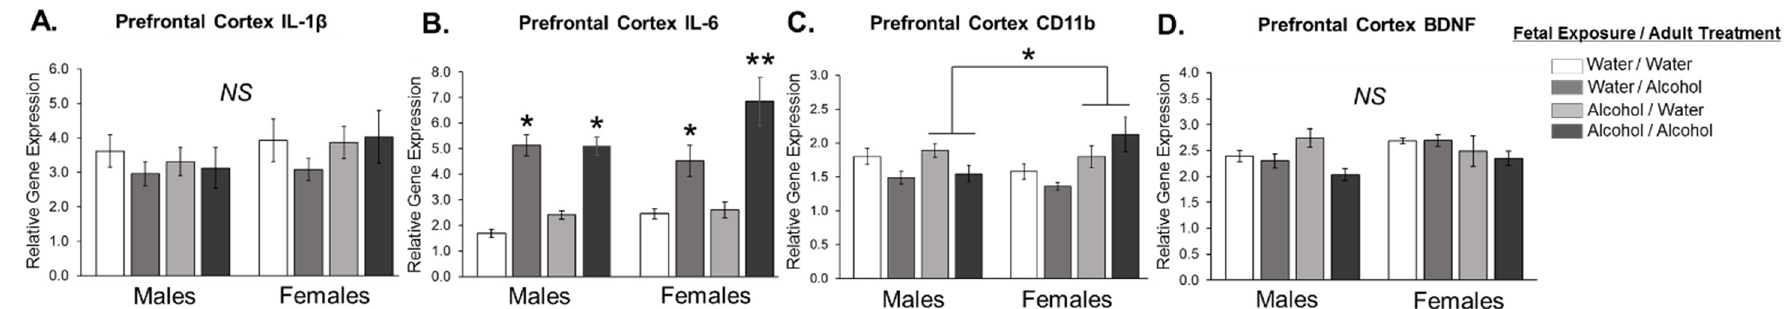
Figure 3. Medial Prefrontal Cortex gene expression in male and female rats exposed to alcohol during fetal development, adulthood, or both. Pregnant dams were treated with alcohol or water on E10 ‐ 16 (2 g/kg, 2×/day). Offspring were allowed to grow up undisturbed at which point they were treated with either an acute dose of alcohol (4.5 g/kg, 2×) or water. Brain tissue was collected 2 h after the last dose of alcohol for the analysis of various cytokines and Brain Derived Neurotrophic Factor (BDNF). ( A ) Analysis of IL ‐ 1 β mRNA revealed no significant differences (NS). ( B ) Analysis of IL ‐ 6 mRNA revealed a significant three ‐ way interaction between sex, prenatal alcohol exposure, and adulthood alcohol treatment on expression levels of IL ‐ 6 ( F 1,62 = 4.485; p = 0.039) and post hoc tests revealed that adult alcohol treatment significantly increased IL ‐ 6 expression relative to water treated controls (* p < 0.05), however, females exposed to alcohol prenatally and then again in adulthood had significantly higher levels of IL ‐ 6 than all other treatment groups (** p < 0.05). ( C ) Analysis of CD11b mRNA revealed a significant interaction between sex and prenatal alcohol exposure ( F 1,62 = 4.318; p = 0.042), * p < 0.05 compared to male rats exposed to alcohol prenatally. ( D ) Analysis of BDNF mRNA in the mPFC revealed no significant differences (NS).